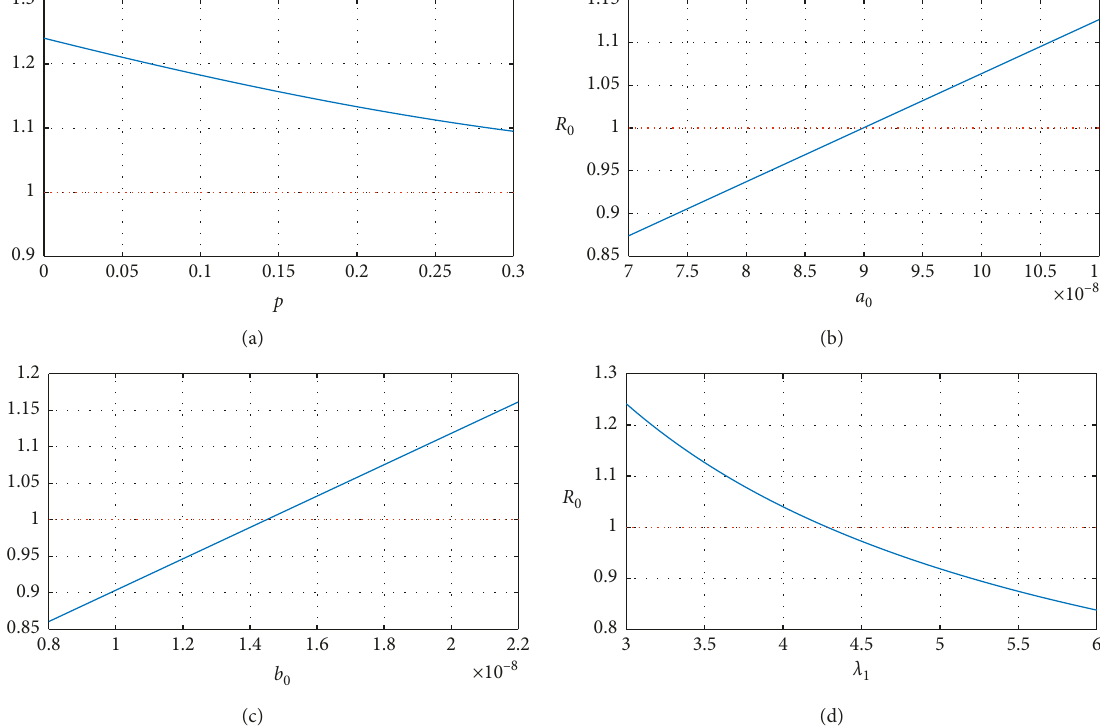
(a) versus p ; (b) versus a 0 ; (d) versus λ . Other parameter values are given in Table 1 2